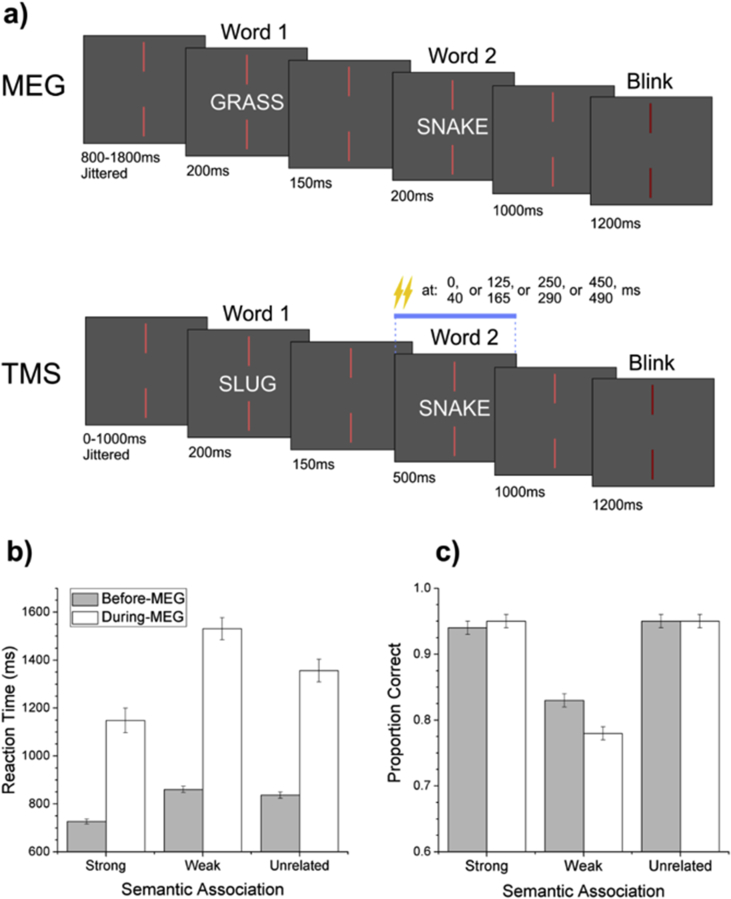
a) Example trials and timelines for the MEG and TMS experiments. b) Reaction time and c) accuracy data from the behavioural (gray bars) and MEG (white bars) experiments. Standard errors are corrected for repeated measures.